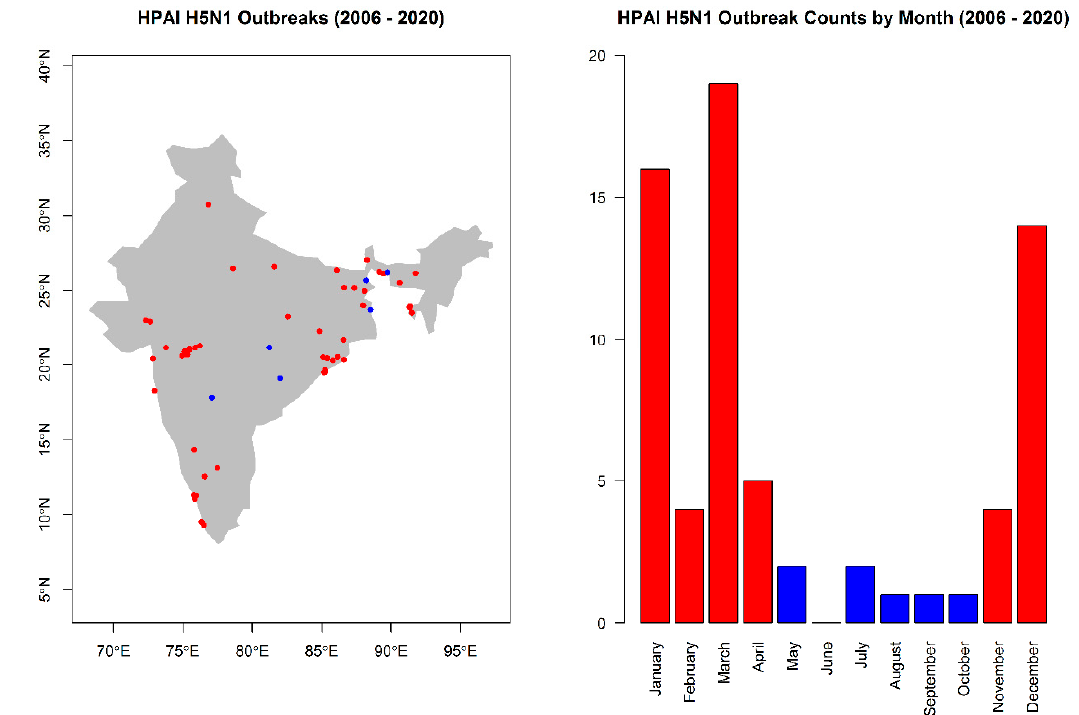
Figure 2. The spatial ( left panel) and temporal ( right panel) distributions of highly pathogenic avian influenza virus, subtype H5N1, outbreaks in India. Outbreaks that occurred during the high season are depicted in red and those that occurred during the low season in blue. The map is displayed only for the purposes of depicting the distribution of disease occurrence, and does not reflect the authors’ assertion of territory or borders of any sovereign country including India.